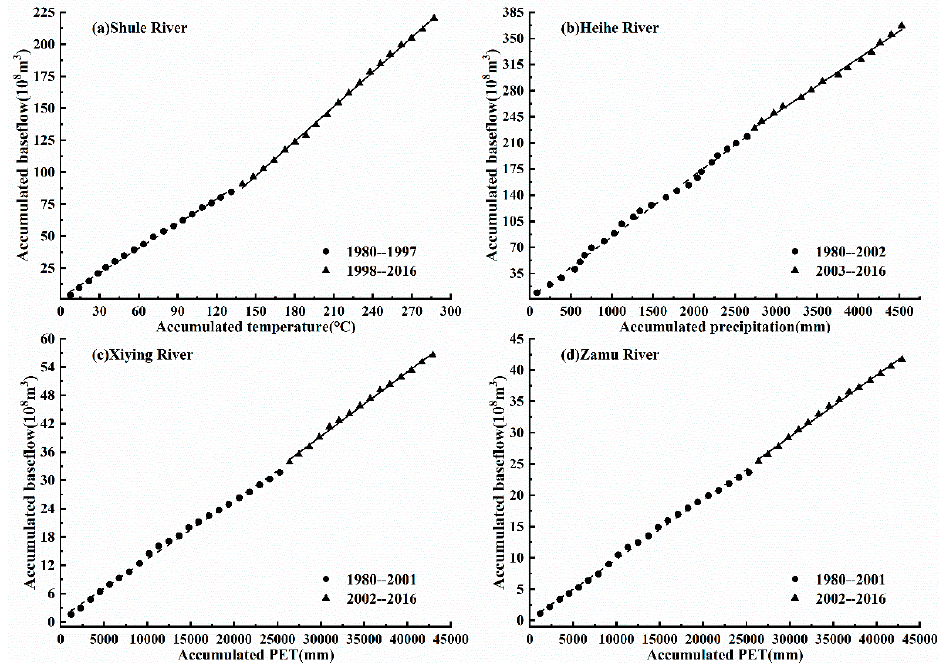
Figure 8. Double-mass curve of the climate-base flow of the Hexi inland rivers basin: ( a ) the Shule River; ( b ) the Heihe River; ( c ) the Xiying River; and ( d ) the Zamu River.